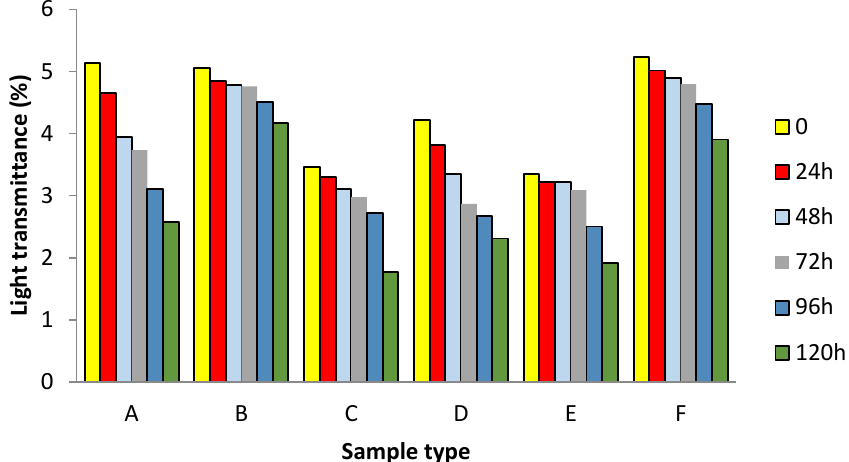
Figure 1. Transmittance of millet starches: A: barnyard millet; B: finger millet; C: foxtail millet; D: kodo millet; E: little millet; F: proso millet.